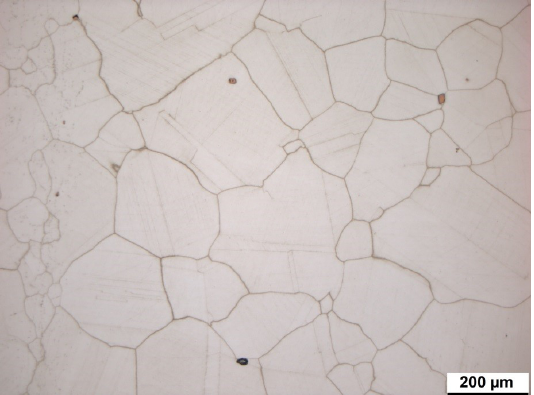
Figure 7. Micrograph of the Inconel-617 under investigation, cell boundaries are emphasized by etching. Micrographs from [32] courtesy of Thomas Schwender (Fraunhofer